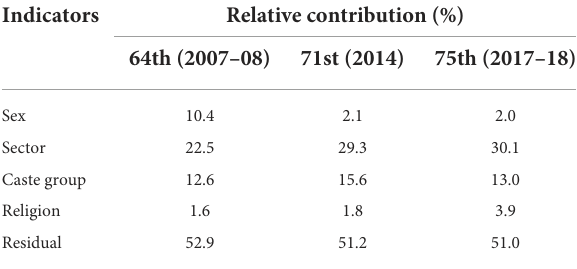
TABLE 7 Shapley decomposition by social